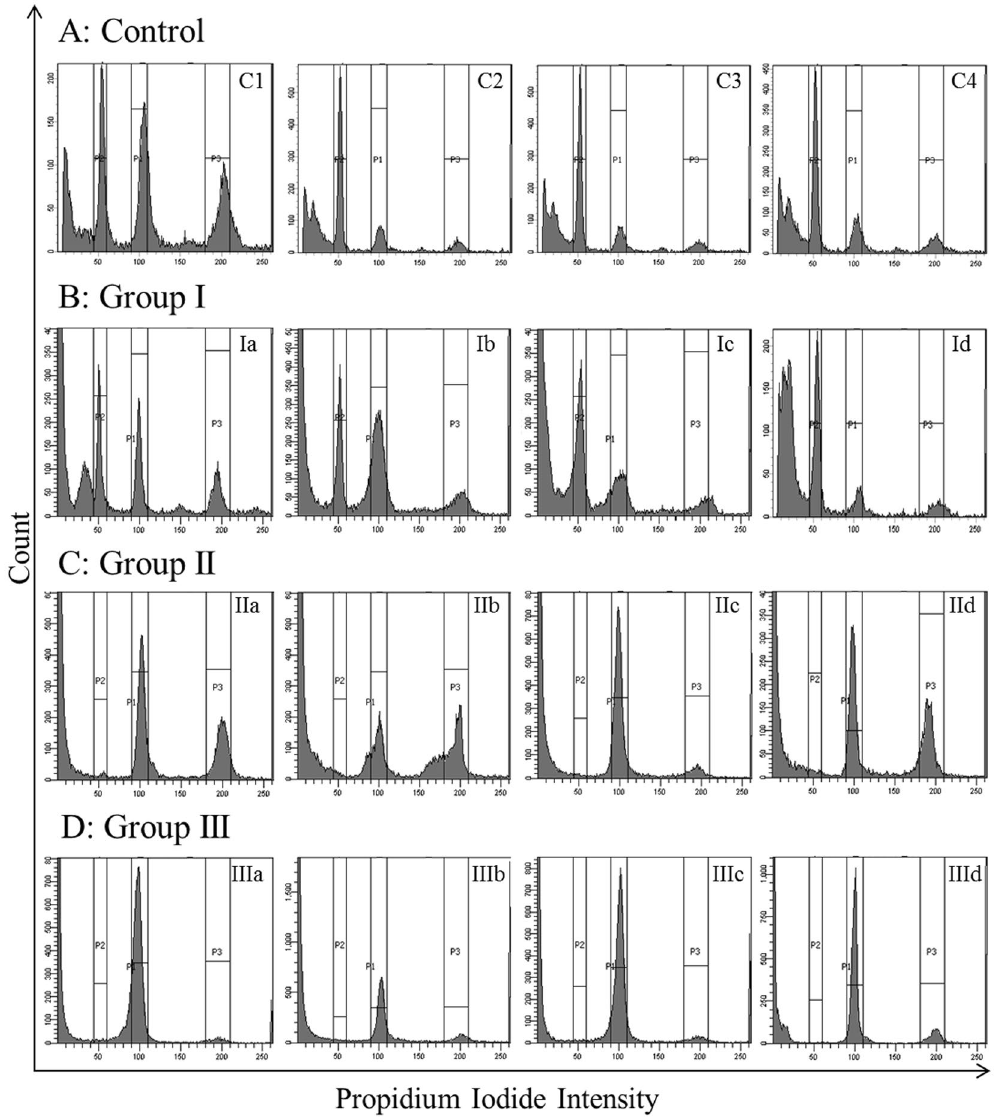
Figure 1. The Germ cell patterns of the control and azoospermic patients. The representative flow cytometric profiles of the testicular biopsy samples as classified into different groups are shown. The testicular tissue samples from the control and azoospermic men were digested with collagenase and the single cell suspensions were fixed with 70% ethanol. The cells stained with PI were analyzed by flow cytometry. Panel A: control- C1-C4; Panel B: Group I – I a-d (obstructive azoospermia, exhibiting haploid, diploid and double-diploid populations); Panel C: Group II – II a-d (NOA with meiotic arrest, exhibiting diploid and double-diploid populations); Panel D: Group III– III a-d (NOA with pre-meiotic arrest, exhibiting diploid populations